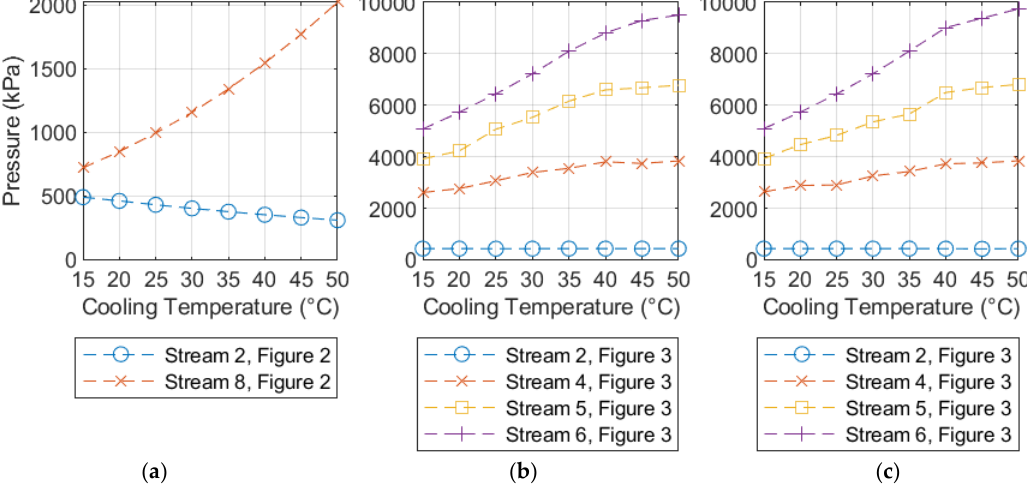
Figure 5. Variation in the optimization parameters for Cases 5a ( a ), 6a ( b ), and 6b ( c ).